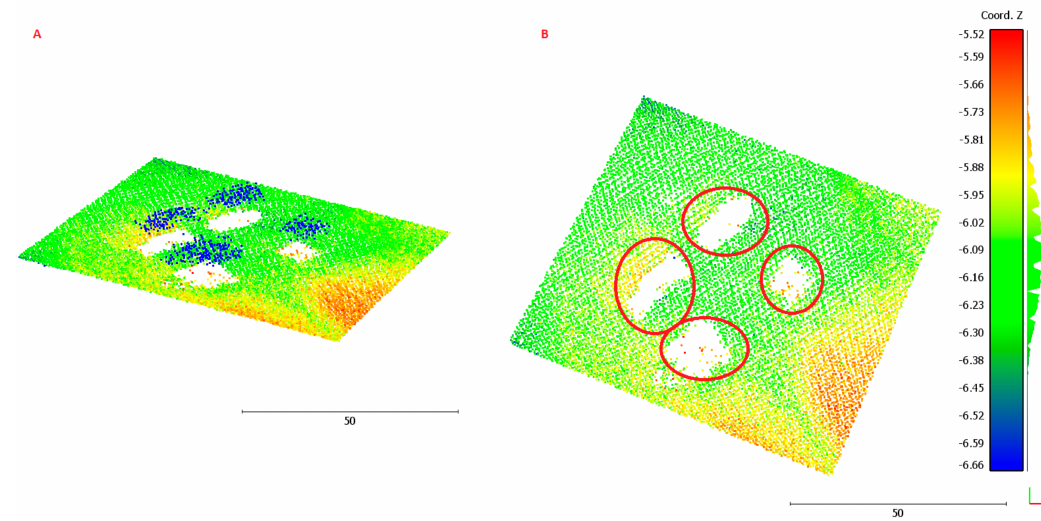
Figure 3. View of the seabed and points with one echo on the water surface (blue) ( A ) and view of the seabed with gaps in data caused by lack of second echo ( B ).